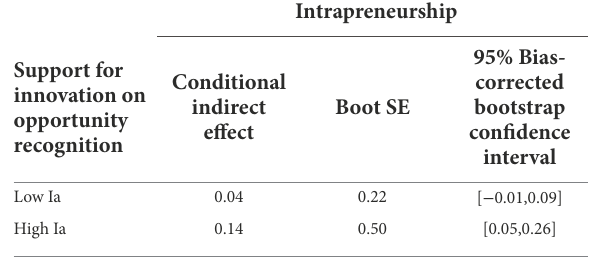
TABLE 8 Moderated mediation results for intrapreneurship across levels of support for innovation for opportunity